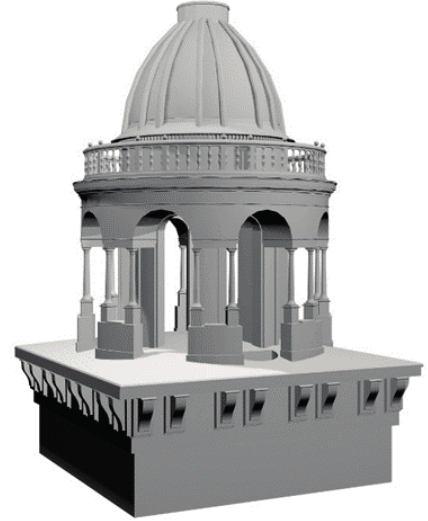
Figure 10. 3D model of the round temple for FEM analysis.